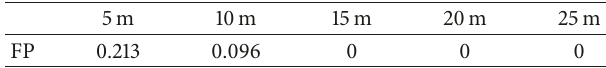
Table 6: FP rates corresponding to the distance between the car and the car key.